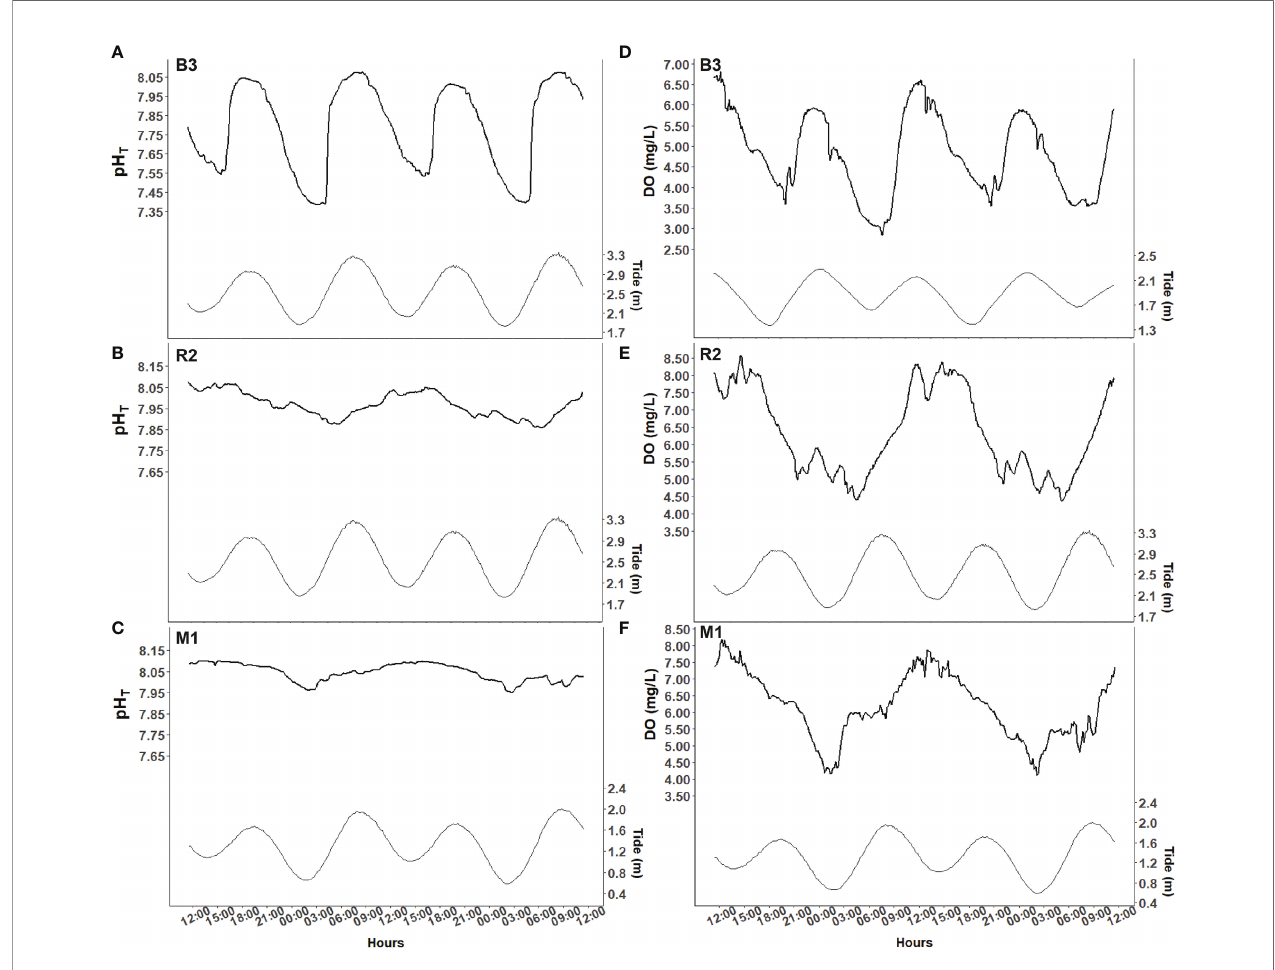
FIGURE 2 | Seawater pH T (A – C) and dissolved oxygen (DO) (D – F) variations (black lines) recorded during 48 hours at Bourake ́ (St B3) and stations R2 and M1. Data were collected at the end of March 2019 at St R2 for pH (B) and DO (E) and at St B3 for pH (A) . DO was measured at St B3 at the beginning of April 2019 (D) . At St M1, data were collected at the end of January 2019 (C, F) . Tidal variations (grey lines) are on the right